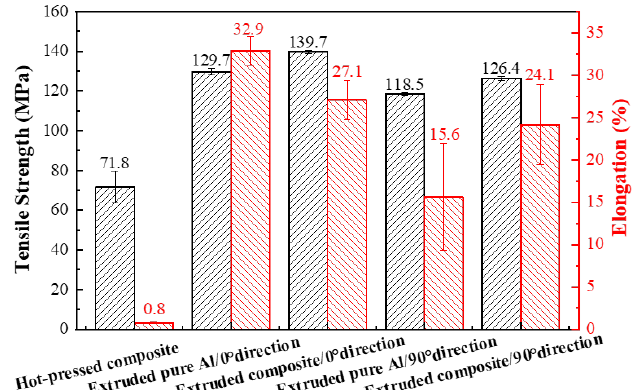
Figure 16. Tensile properties for composites and pure aluminum.